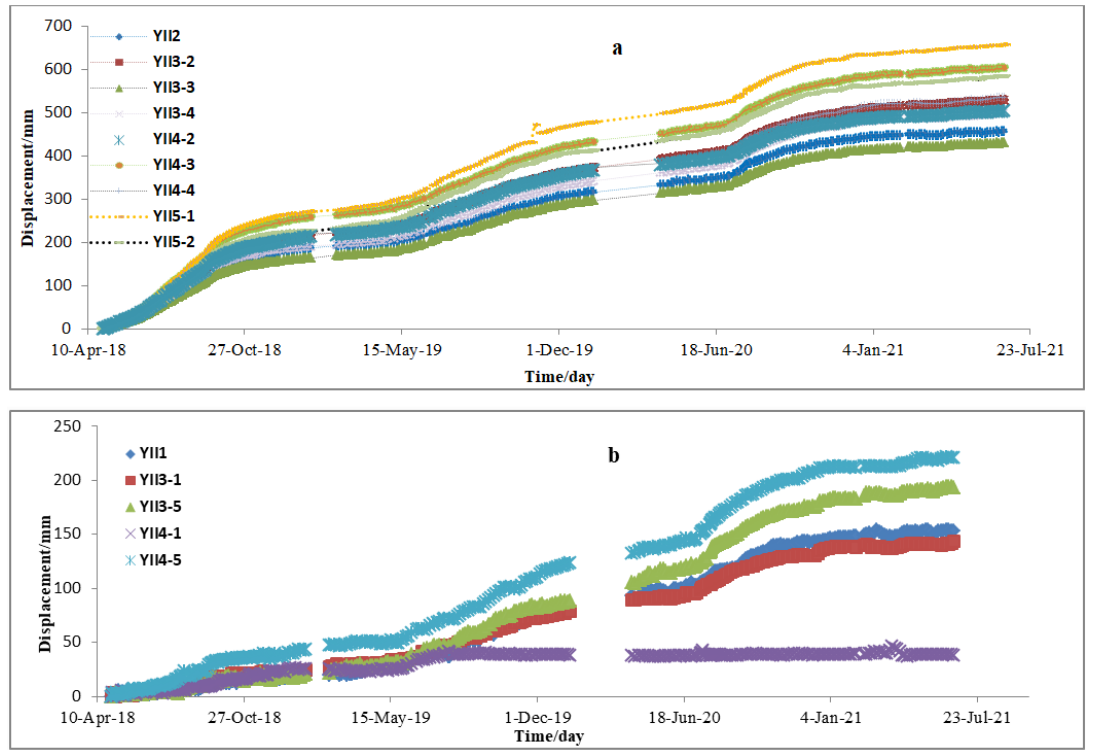
Figure 6. Surface displacement with time: ( a ) within the landslide mass and ( b ) outside the boundary of the landslide mass.